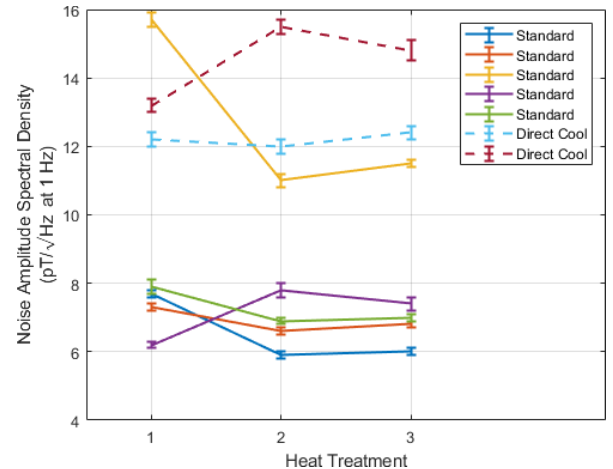
Figure 11. Comparison of ring cores manufactured with an initial standard heat treatment (solid) versus those with a direct cooling (dashed). Heat treatments 2 and 3 were each 100h at 100 ◦